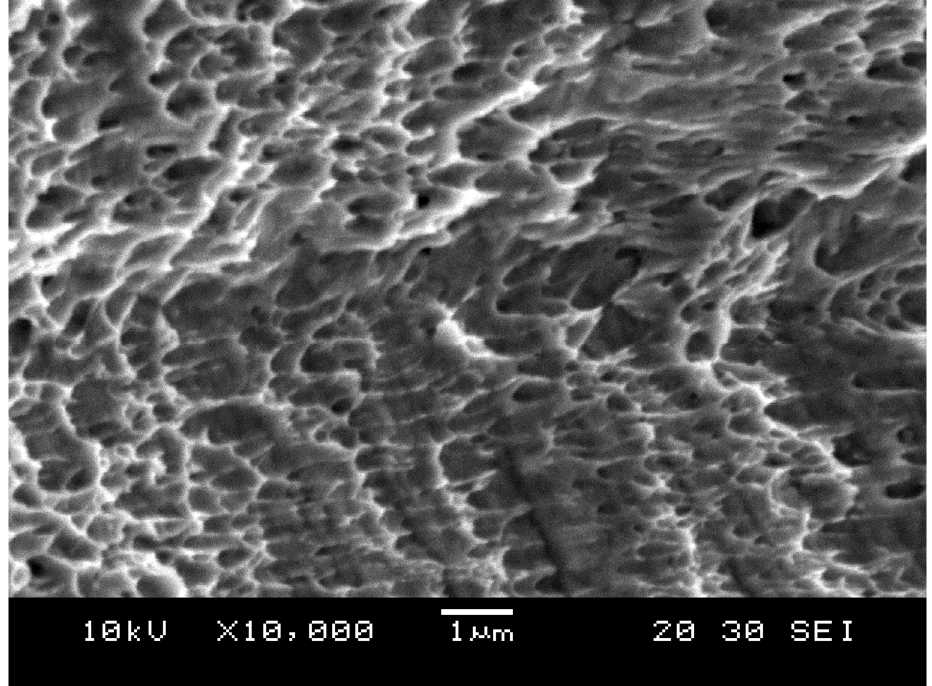
Figure 15. Dimple fracture.